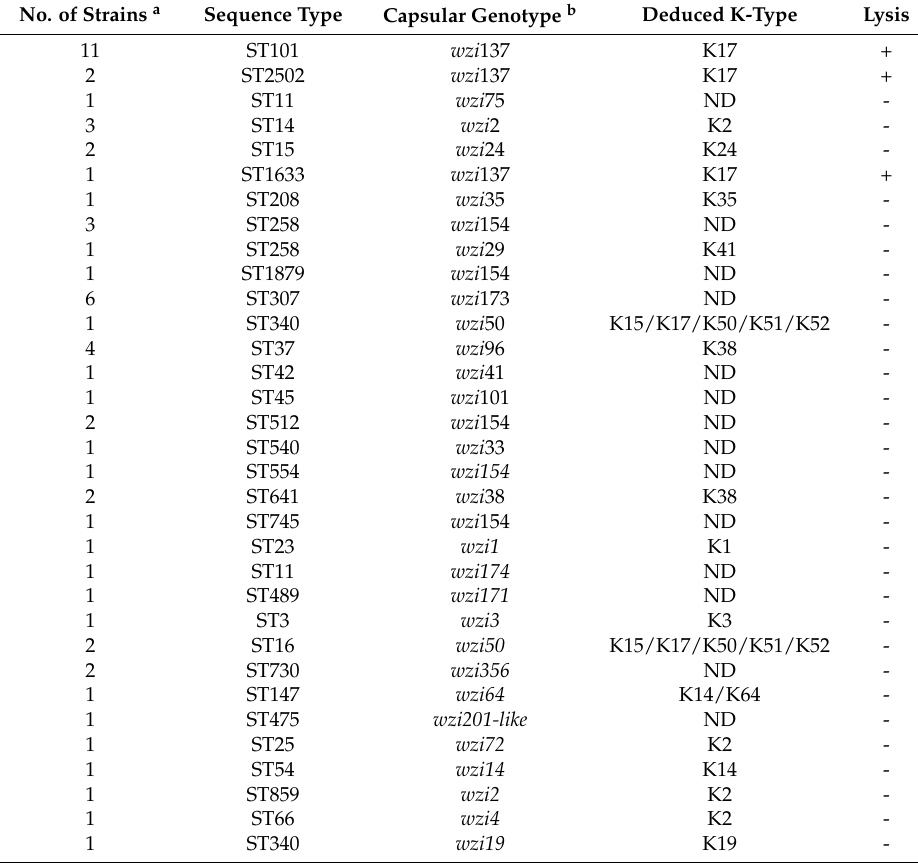
Table 1. Host spectrum of vB_Kpn_F48 towards K. pneumoniae clinical isolates. For each combination of sequence type/capsular genotype, the number of tested strains, the deduced capsular type basing on the wzi sequencing method and the result of the lysis test are reported (- = all strains were not lysed; + = all strains were lysed; ND = Not